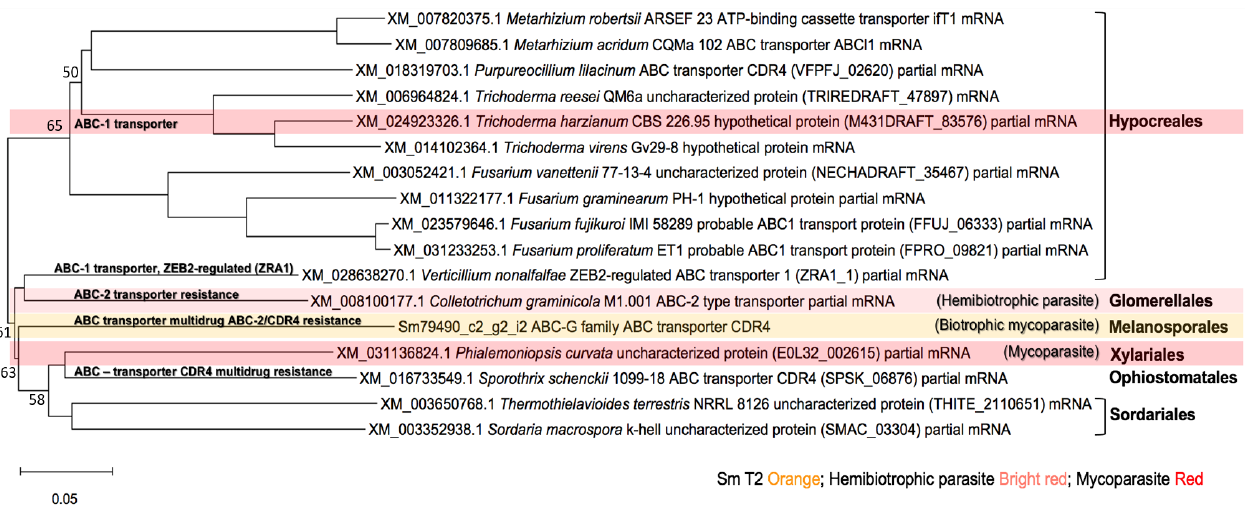
Figure 8. The unrooted phylogenetic tree for the ABC-G family transporters in S. mycoparasitica was built with MEGA-X using the minimum evolution method [39]. The branch support bootstrap (>50%) values were obtained by 1000 replicates using the NJ method. Sm T2 (orange color) represents S. mycoparasitica interacting with the host for 3.5 days incubation time. The hemibiotrophic parasite and the mycoparasite were highlighted in bright red and red colors, respectively.